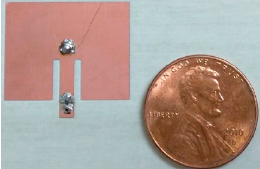
Figure 40. Low-power/low duty cycle rectenna RF EH device powered by a nearby aircraft altimeter radar [215].